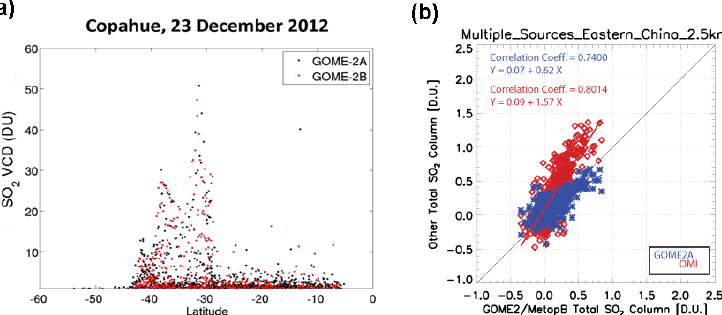
Figure 13. Example of SO 2 validation activities: (a) comparisons of SO 2 columns retrieved from GOME-2A and GOME-2B for the Copahue eruption, as a function of latitude and (b) scatter plot of anthropogenic SO 2 (assuming a 2.5km plume height ) over eastern China from GOME-2B ( x axis) and, respectively, GOME-2A (blue) and OMI